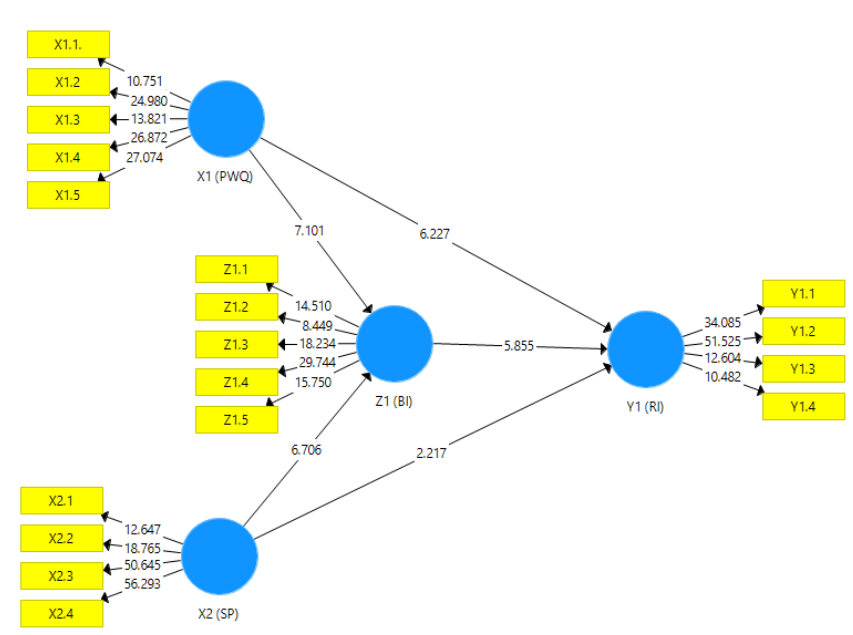
Figure 2: Direct Effect Test Results; Source: Processed Primary Data